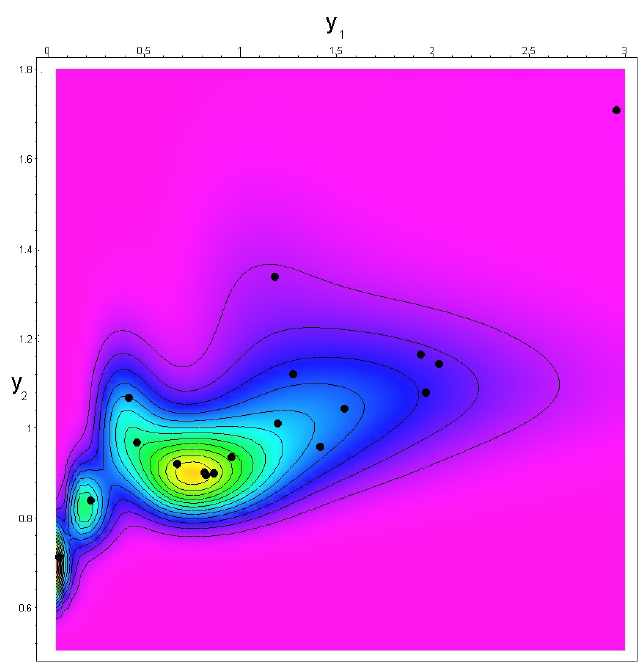
Figure 8. Contour plot of ˆ g ( y 1 , y 2 ) , m =